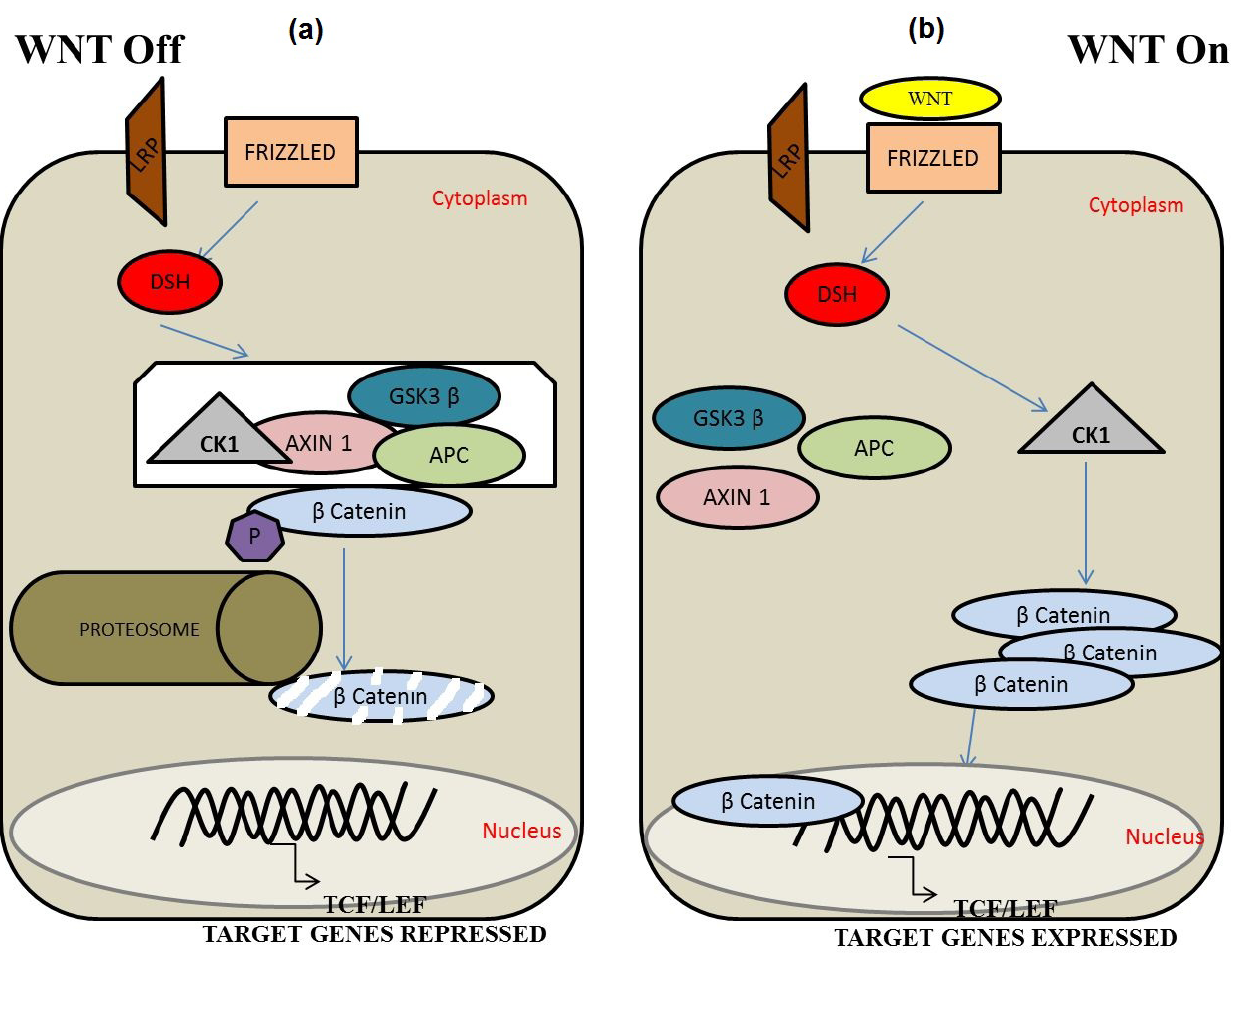
FIGURE 2 - Schematic WNT signaling (a) In the absence of ligand, A degradation complex, consisting tumor suppressors axin- 1 (AXIN 1), adenomatous polyposis coli (APC), the constitutively active kinases glycogen synthase kinase 3β (GSK3β) and casein kinase I (CK 1) phosphorylates β-catenin leading to proteasomal degradation. (b) In the presence of ligand, the ligand binds to Frizzled and low-density lipoprotein receptor-related protein (LRP) receptors, leading to the inactivation of destruction complex. β-catenin accumulates in the cytoplasm and is translocated into the nucleus binding to the transcription factors of the T cell factor/lymphocyte enhancer factor (TCF/LEF)